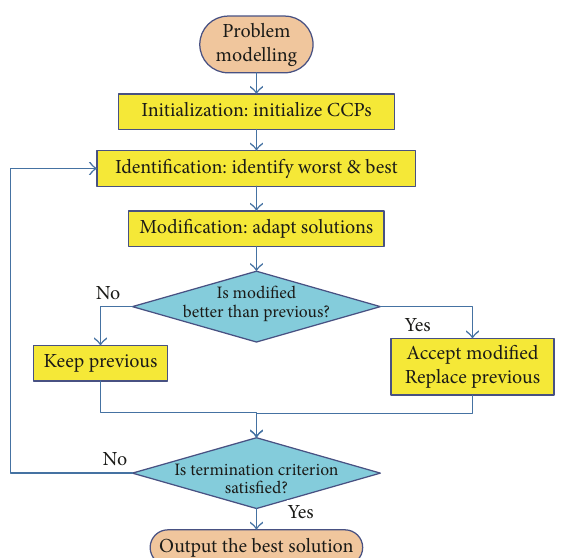
Figure 5: Diagram of Jaya